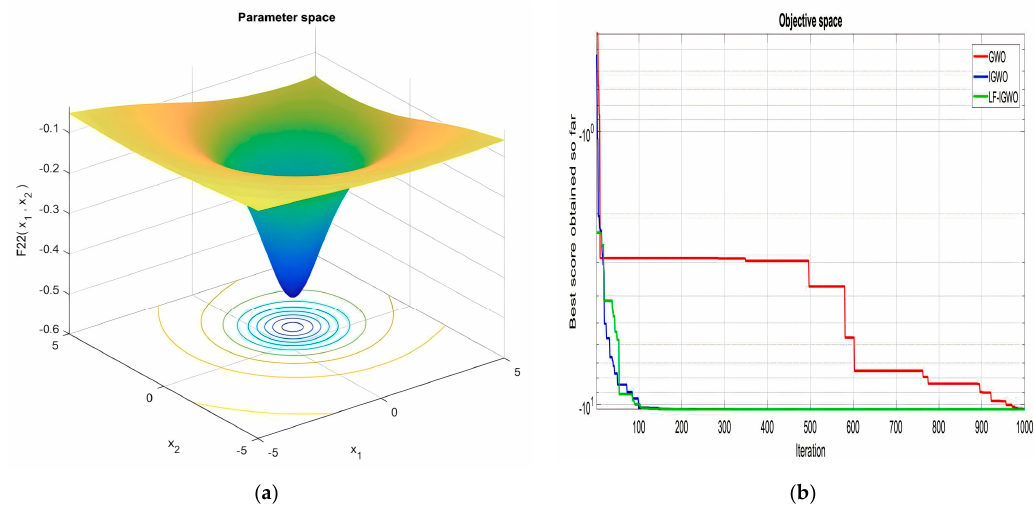
Figure 24. ( a ) Search space for fixed dimensional function F22 ( b ) Comparison of convergence curve for F22.